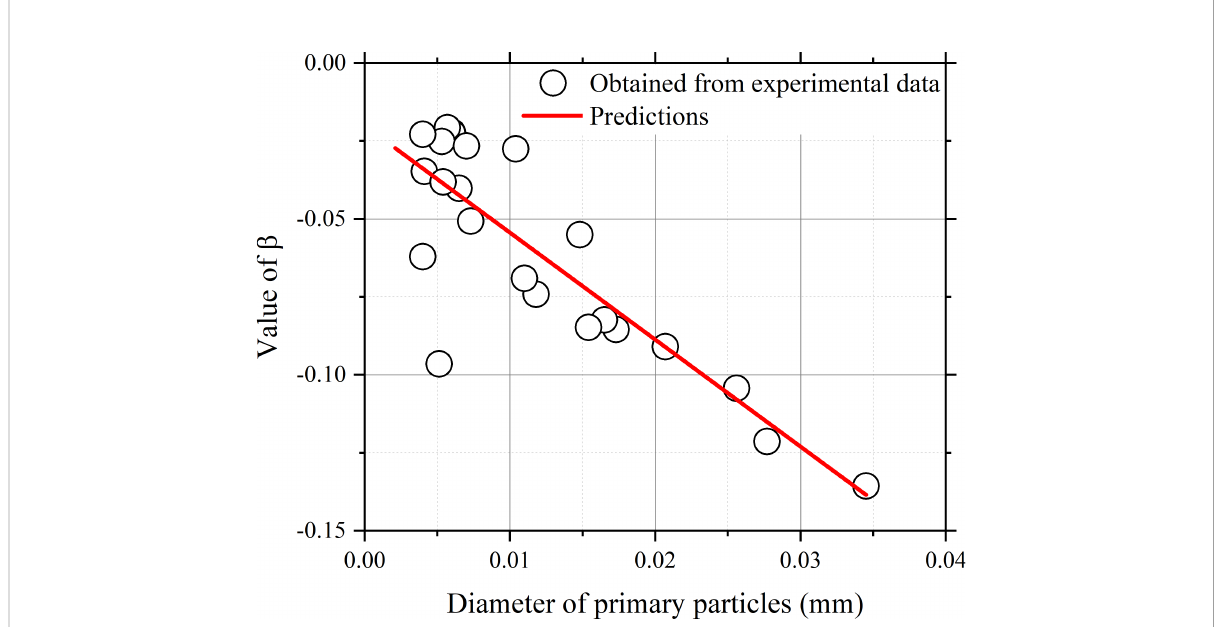
FIGURE 5 The value of b varying with the diameter of primary particles.